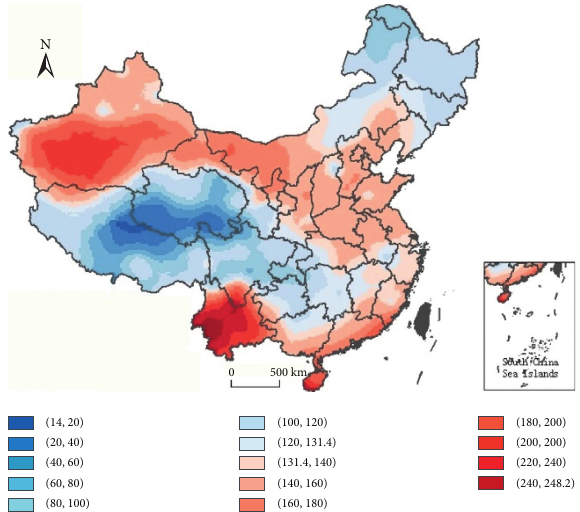
Figure 2: The spatial pattern of the annual average TCCP in China